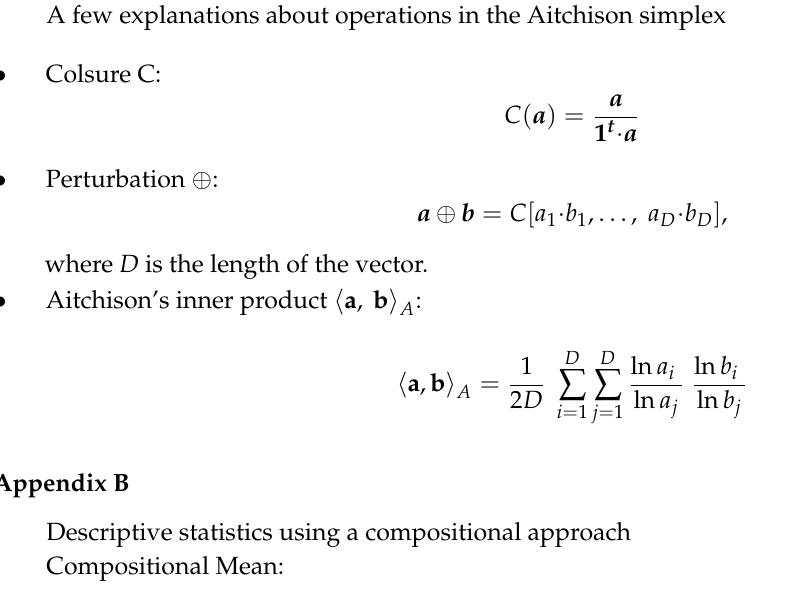
Table A1. Covariance matrix of the budget time of lying, sitting, standing, light physical activity and moderate-to-vigorous activity in the population. Behavior Lie Sit Stand LPA MVPA Lie 1.3334 − 0.3297 − 0.3355 − 0.3016 − 0.3666 Sit − 0.3297 0.2170 0.0380 0.0208 Stand − 0.3355 0.0380 LPA MVPA −